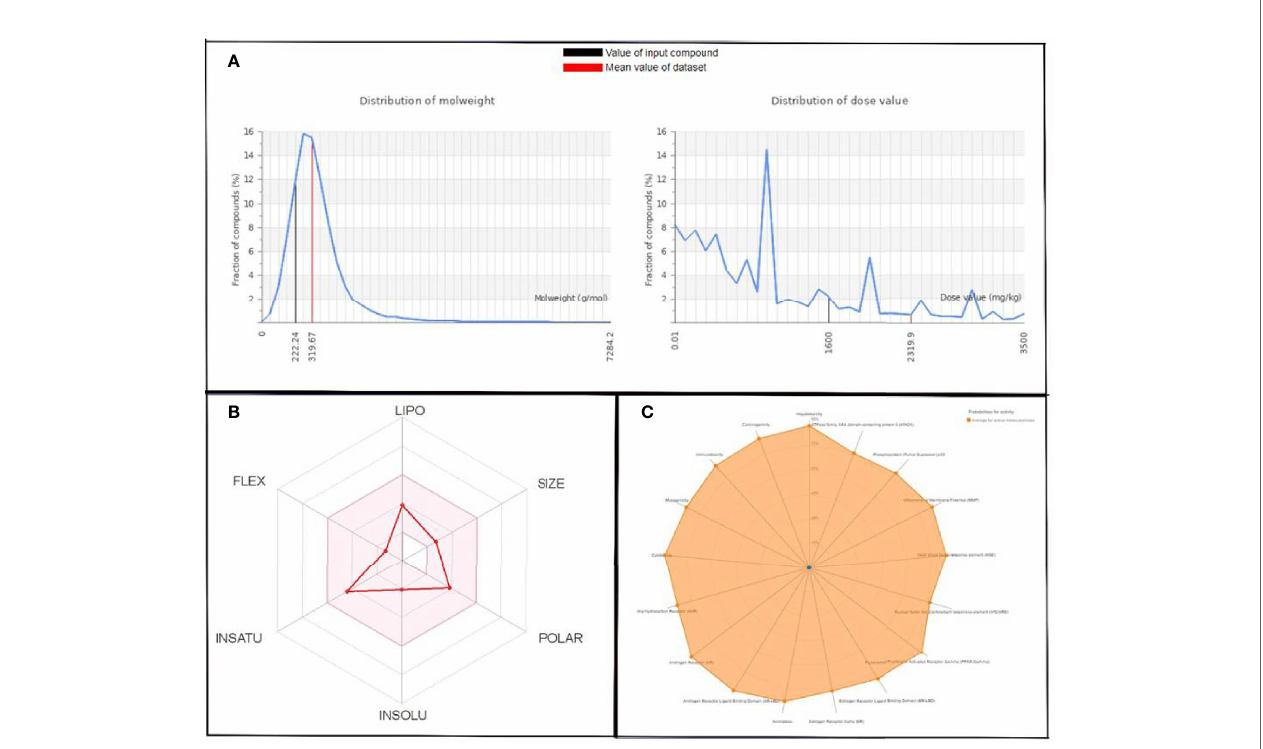
FIGURE 5 | (A) Graphical representation of molecular weight and dose value distribution of QSSM 1157. (B) Swiss-ADME generated bioavailability radar chart for QSSM 1157. Pink area indicates the oral bioavailability of QSSM 1157. (C) Radar chart showcasing various toxicity pro fi les of QSSM 1157 predicted through